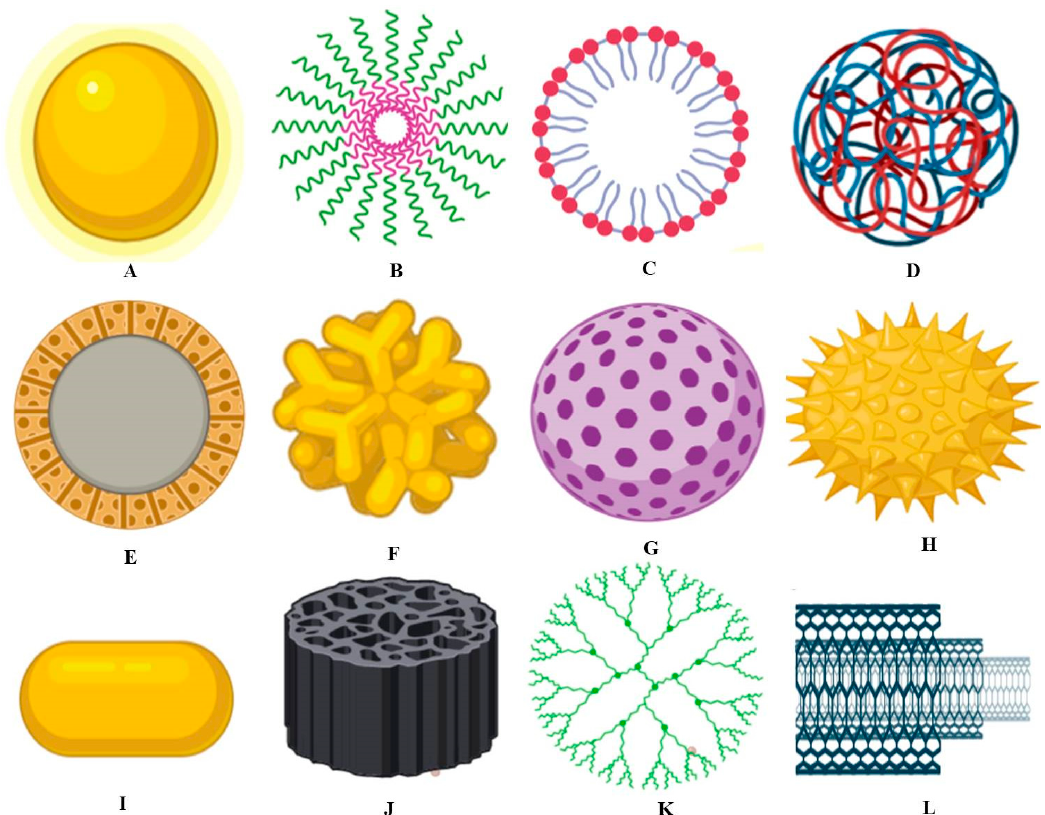
Figure 3. Graphical representation of different types of nanomaterials used in the food industry. ( A ) Metallic nanoparticles, ( B ) Polymeric micelle, ( C ) Liposomes nanoparticles, ( D ) Polymeric nanoparticles, ( E ) Solid-core mesoporous nanoparticles, ( F ) Branched gold nanoparticles, ( G ) Mesoporous nanoparticles, ( H ) Surface functionalized nanoparticles, ( I ) Nanorod, ( J ) Porous silica nanoparticles, ( K ) Dendrimer, ( L ) Carbon